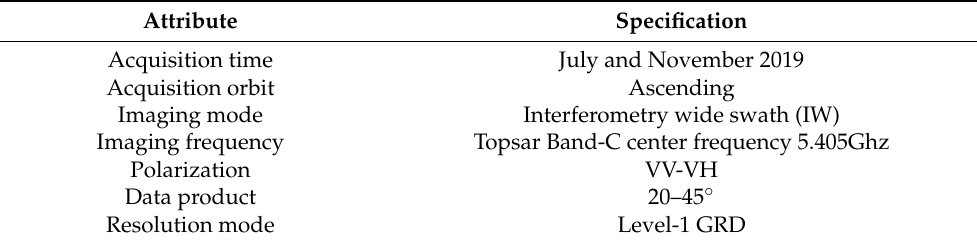
Table 1. Sentinel-1A image specifications.